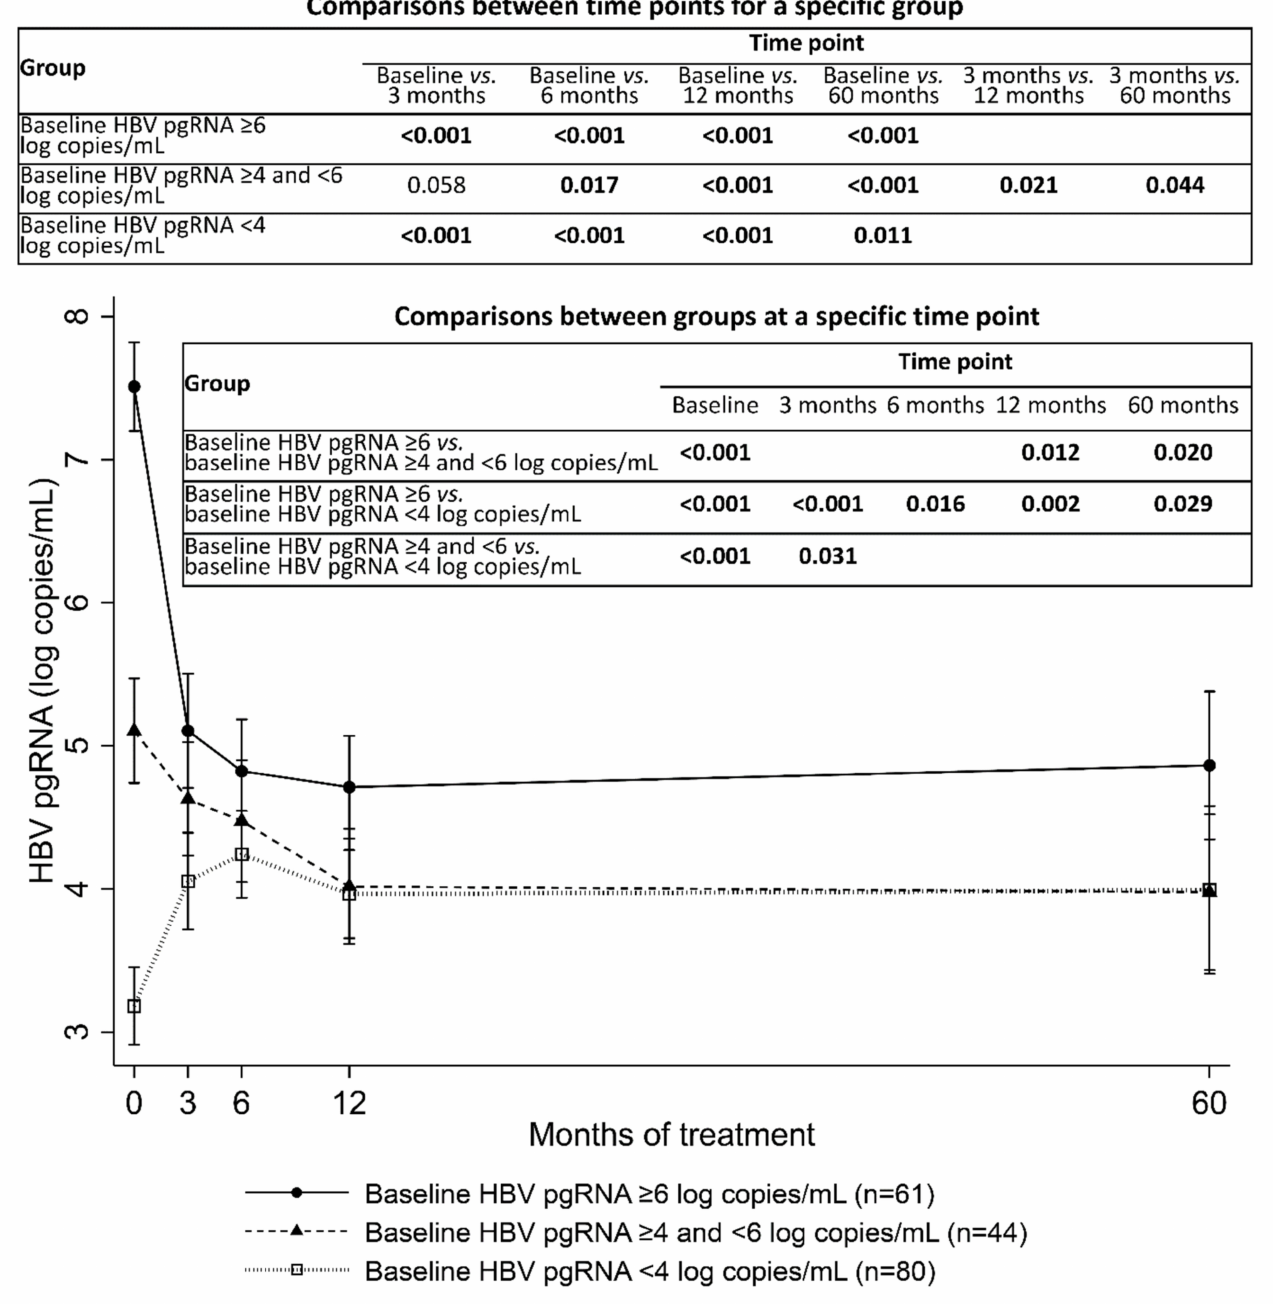
Figure 2. Serum HBV pgRNA kinetics during entecavir treatment, categorized by baseline serum HBV pgRNA levels. Error bars represent 95% confidence intervals. Significant p values and one borderline p value are